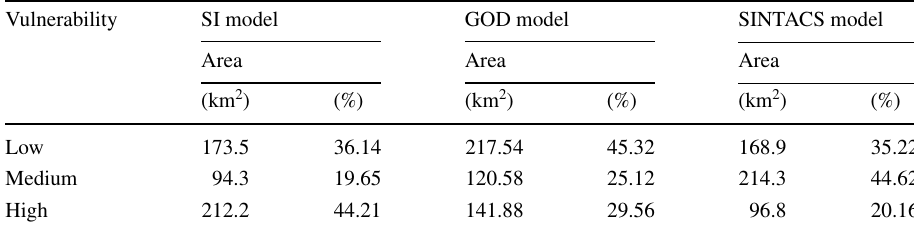
Table 2 Evaluation criteria of degree of vulnerability in SI, GOD and SINTACS models